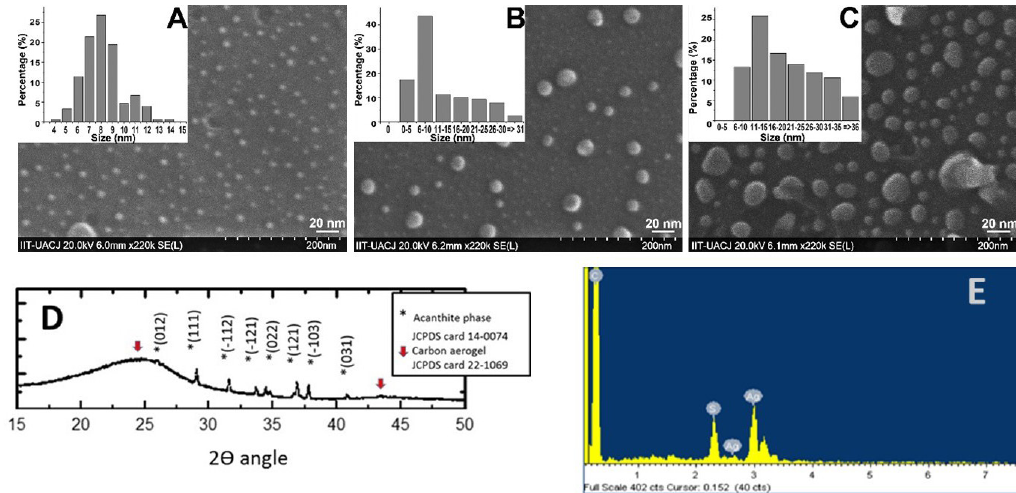
S NPs with different time of silver deposition, A)5 s, B)7 s and C)45 s silver 2